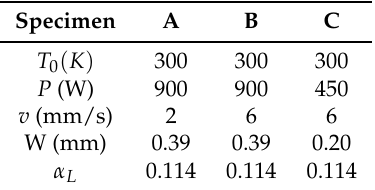
Table 1. Processing parameters as reported in Wang et al.